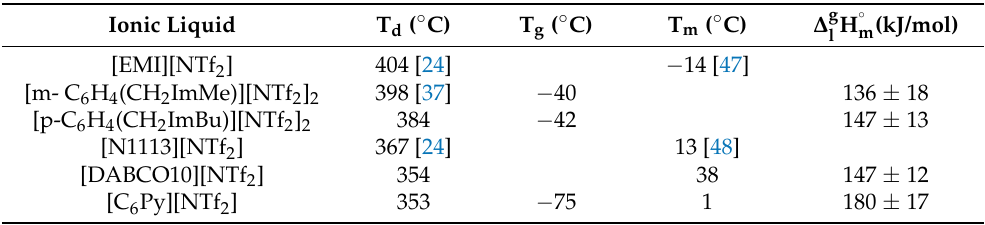
Table 2. Decomposition (T d ), glass transition (T g ), melting (T m ) temperatures and vaporization enthalpy ( ∆ g H ◦ m ) of the investigated l